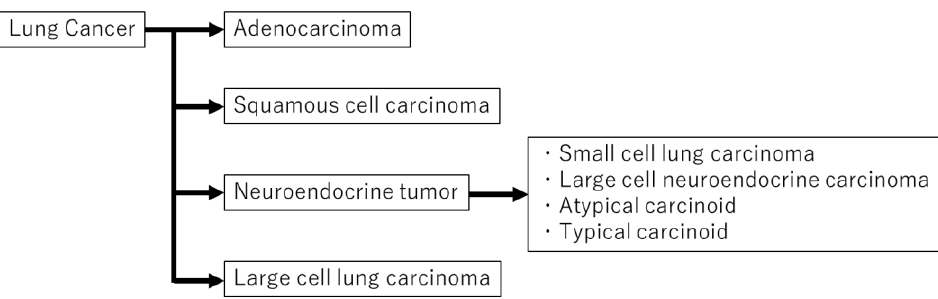
Figure 1. Lung cancer can be divided into four major types. Neuroendocrine tumors are subdi- vided into small cell lung carcinoma, large cell neuroendocrine carcinoma, atypical carcinoid, and typical carcinoid.